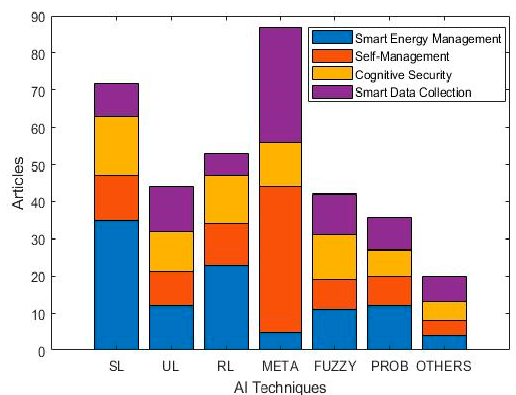
Figure 9. Trend of CS solution classification last over the decade.